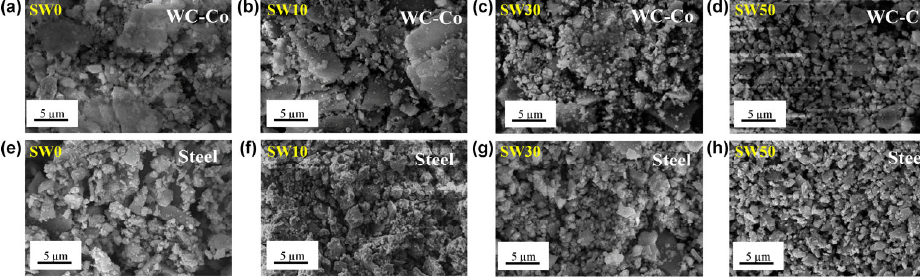
Fig. 12 SEM images of debris collected after wear of SiC-WC composites against WC-Co and steel counterbodies at 20 N